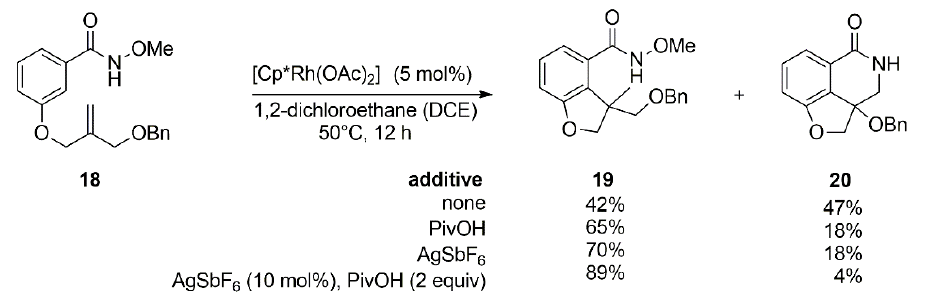
Figure 11. Aryl hydroxamate C(sp 2 )–H functionalizations with tethered alkenes: selectivity of achiral ligand and proper acid additive.